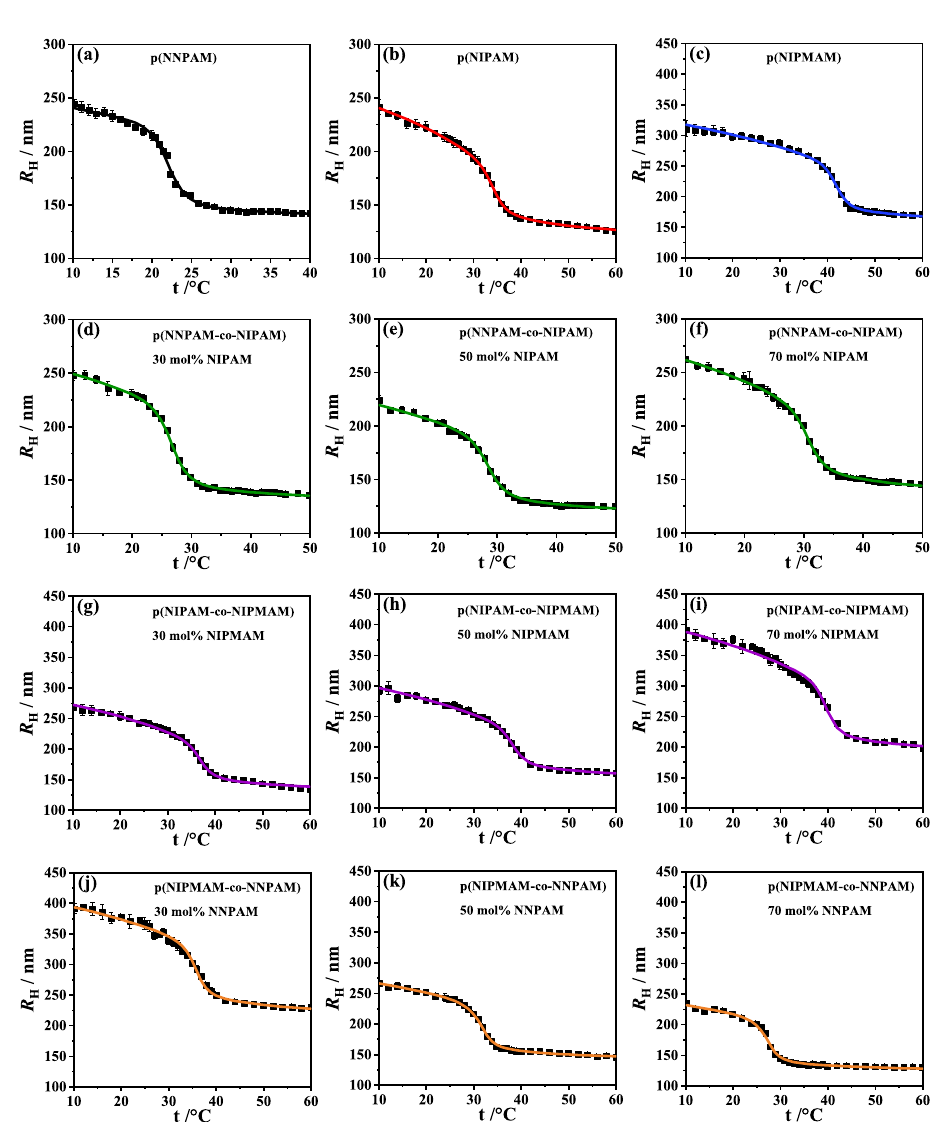
Figure 2. Hydrodynamic radius R H vs. temperature t of the homopolymer systems poly(NNPAM) ( a ), poly(NIPAM) ( b ) and poly(NIPMAM) ( c ) and of the copolymer systems poly(NNPAM-co-NIPAM) ( d – f ), poly(NIPAM-co-NIPMAM) ( g – i ) and poly(NIPMAM-co-NNPAM) ( j – l ) at different comonomer contents (30 mol%, 50 mol% and 70 mol%). Squares are experimental data, solid lines represent the fitting curves. R H ( t ) of the homopolymer systems was calculated using the Flory–Rehner Equation (7) for homopolymers. For the fit of the hydrodynamic radii R H ( t ) of the copolymer systems the modified Flory–Rehner Equation (6) for copolymer networks was used. The interaction parameter χ s , i was calculated with the Hill-like Equation (11) for both monomers, respectively. A nearly perfect fit to the experimental data was achieved for all microgel